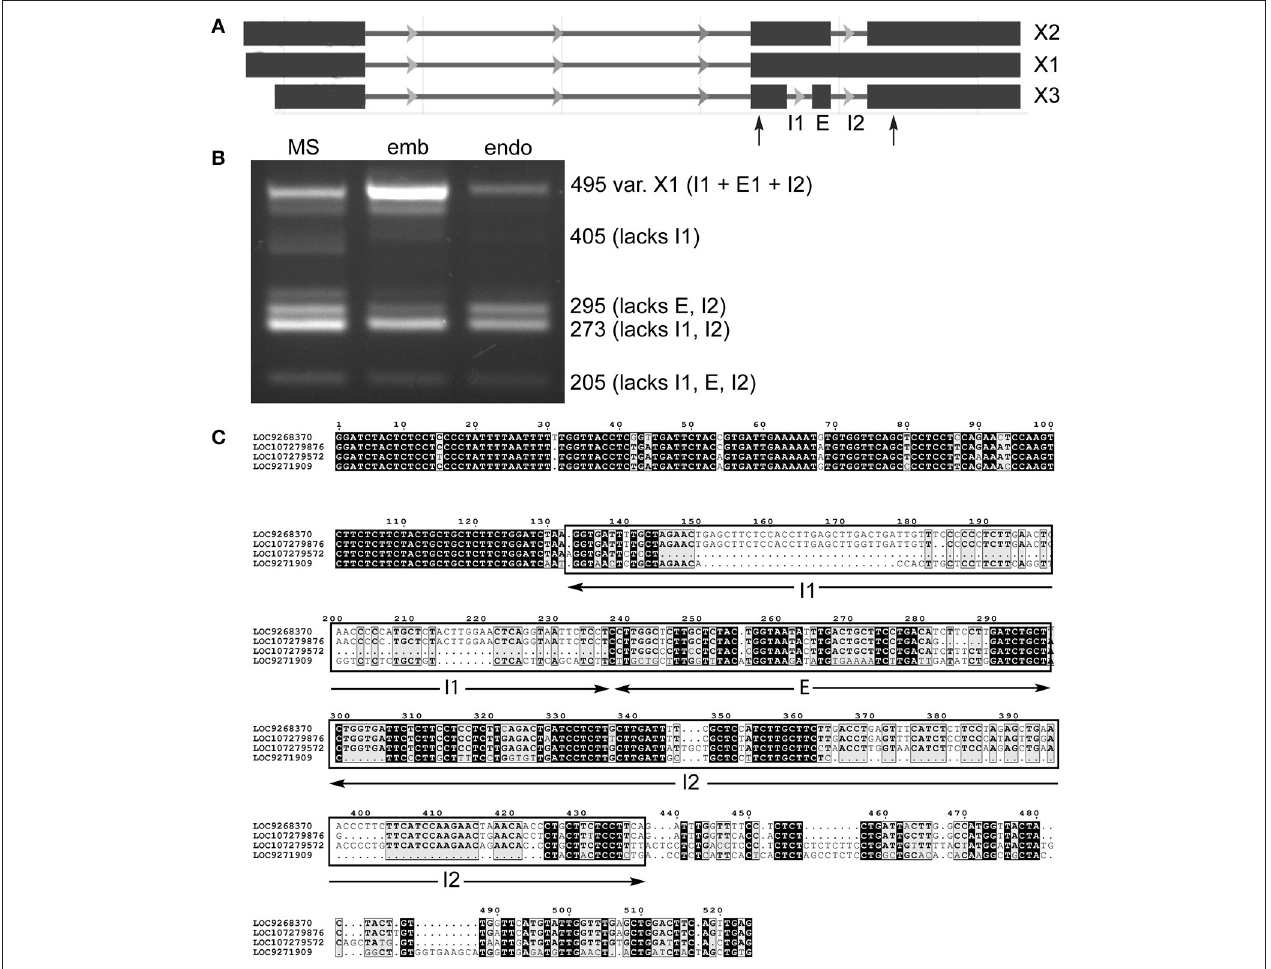
FIGURE 4 | Alternative splicing of lncRNA LOC107279876 retained introns in milk seed, embryo, and endosperm. (A) Gene structure. Primers flanking retained introns and skipped exon are indicated by arrows. (B) PCR amplicons containing different splice variants (MS, milk seed; emb, embryo; endo, endosperm). (C) alignment of conserved ncRNA sequences on chromosomes 2, 1, 12, and 8, respectively.